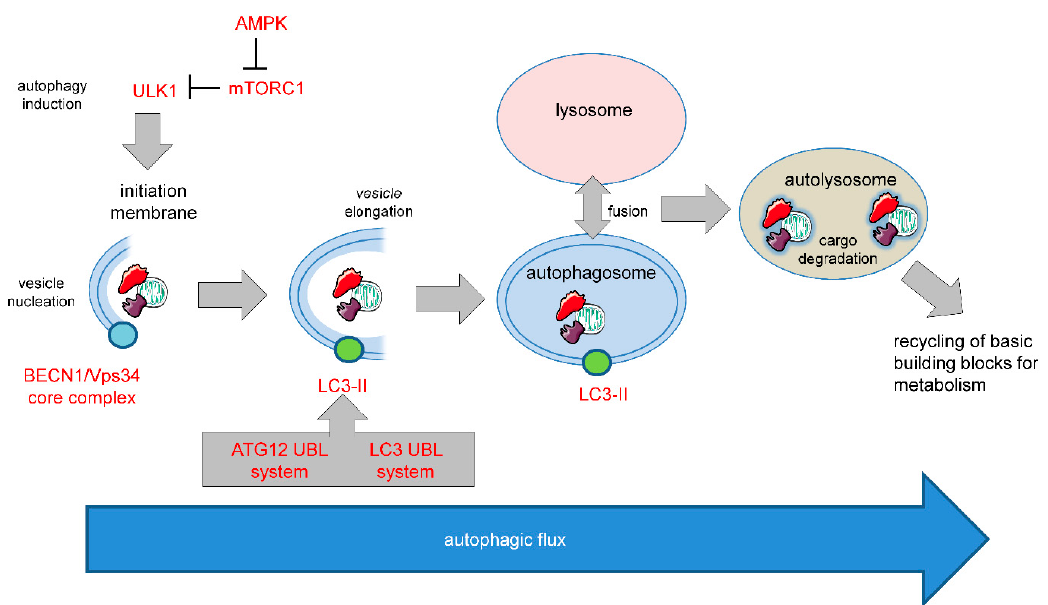
Figure 1. Molecular basis of mammalian autophagy. Autophagy is a multistep process involving several key ATG proteins and signaling complexes. It requires the formation of double-membrane-containing autophagosomes that sequester proteins, lipids, organelles or invasive microbes and fuse with lysosomes for digestion of content by acidic hydrolases. ULK1, a protein kinase serving as the central initiator of autophagy, is inhibited by the mTORC1 complex that contains mTOR. AMPK serves as a nutrient sensor and negative regulator of mTORC1. Autophagosome biogenesis starts with the formation of an initiation membrane that is derived either from the endoplasmatic reticulum (ER) or from several other cellular membrane sources. Vesicle nucleation is promoted by the BECN1 / Vps34 core complex containing the lipid kinase Vps34. Vesicle elongation is regulated by the two ubiquitin-like conjugation systems (UBLs) ATG12-UBL and LC3-UBL that cooperate to catalyze the conjugation of phosphatidylethanolamine (PE) to LC3 and facilitate the conversion of cytosolic LC3-I into a membrane-associated LC3-II that is translocated to the autophagosomal membrane. Following vesicle closure, mature autophagosomes fuse with lysosomes to generate autolysosomes that digest the autophagosomal content by lysosomal proteases for cellular recycling [5]. This figure was created using Servier Medical Art templates, which are licensed under a Creative Commons Attribution 3.0 Unported License; https: //